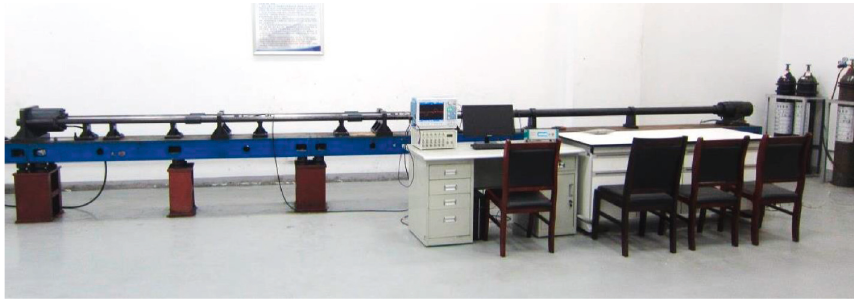
Figure 2: SHPB test